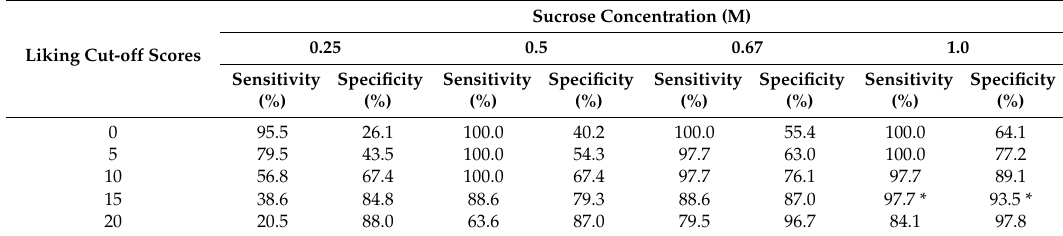
Table 3. Sensitivity and specificity checks to discriminate sweet likers (cluster 1) from the rest of sweet taste liker phenotypes.